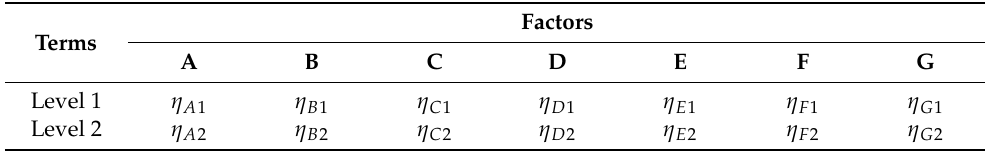
Table 5. A response table from the L 8 (2 7 ) orthogonal